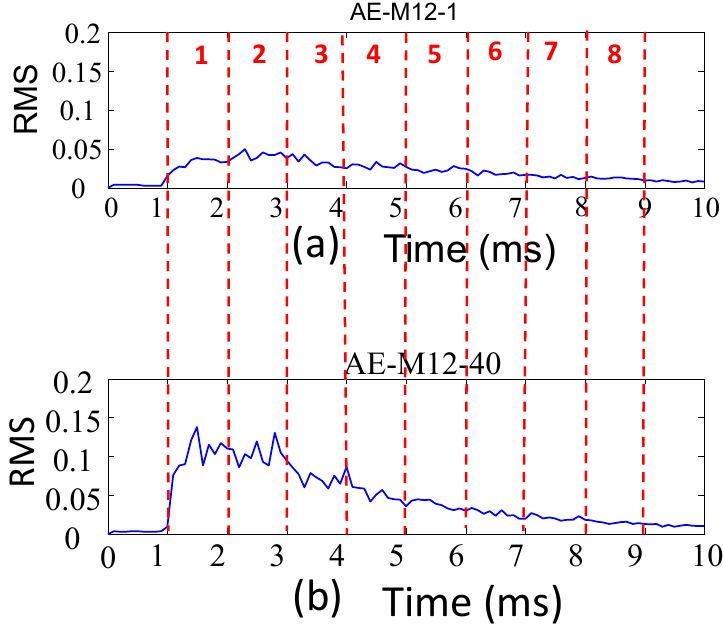
Figure 11. Intervals of AE signals for ( a ) low and ( b ) normal joint strength.